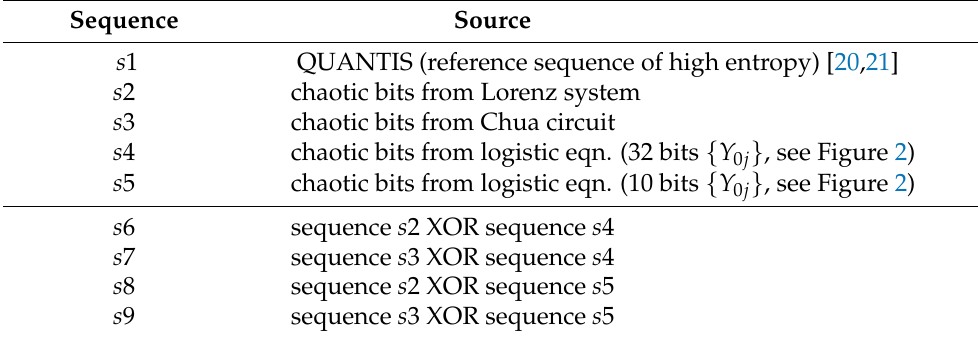
Table 1. Sources of bit sequences used in this